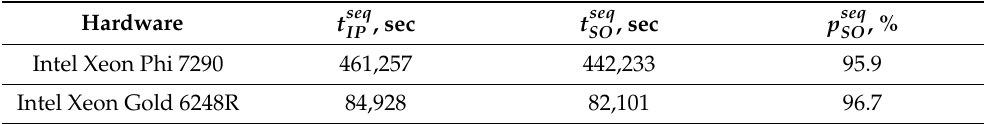
Table 1. Time results of sequential execution of the source identification algorithm with the considered scenario: t seq is the total time of the inverse problem solution; t seq is the total time of the sensitivity IP SO = t seq / t seq operator matrix construction; p seq is the fraction of the time of inverse problem solution IP SO SO spent for sensitivity operator matrix